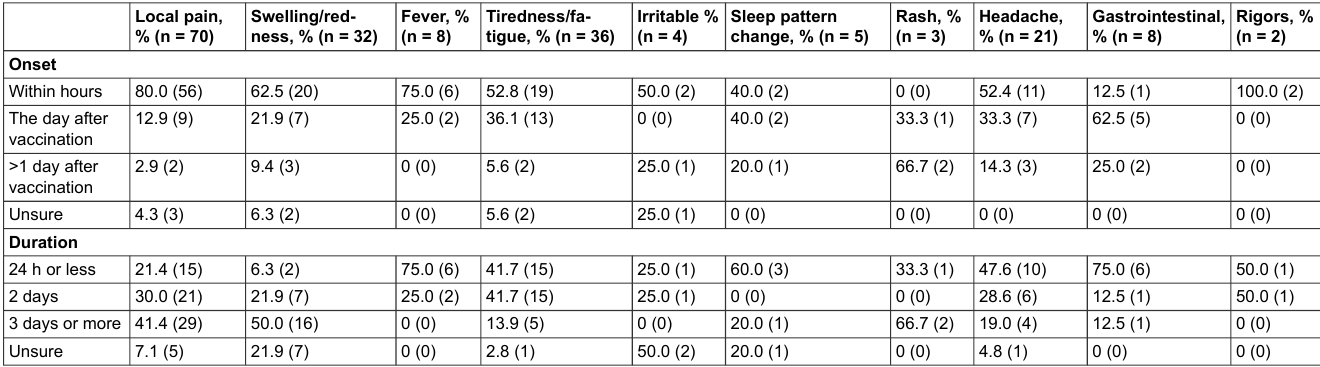
Table S2 : Onset and duration of AEFI.